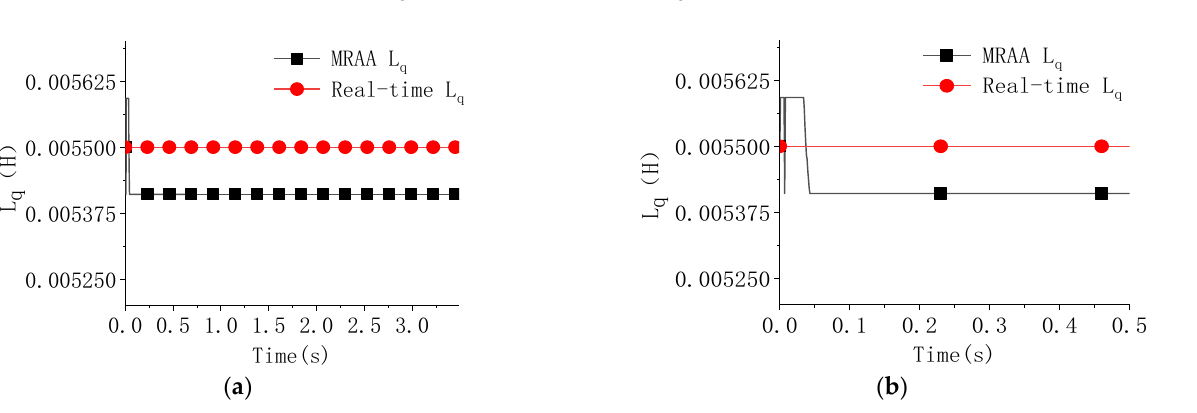
Figure 12. Comparison between the MRAA-identified L q and the actual L q . ( a ) Comparison of L q and ( b ) the local magnification of the anterior segment.